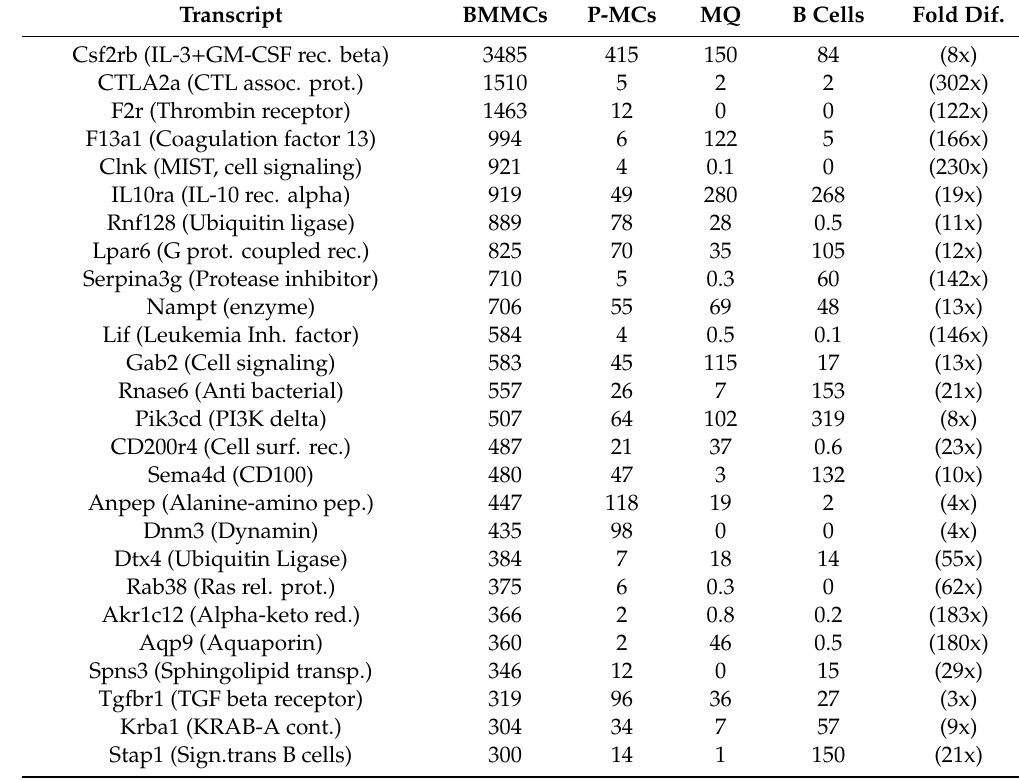
Table 3. Transcripts found at high levels in BMMCs but at low levels in mature peritoneal MCs. The table depicts the number of reads for each transcript. The right column depicts the fold di ff erence in transcript levels between BMMCs vs.